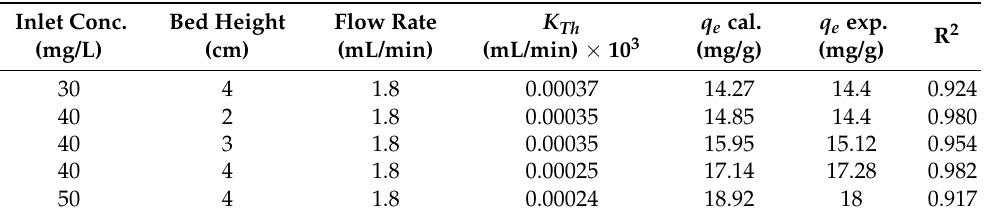
Table 5. Thomas model parameters for the adsorption of 2,4,6-TCP onto FeCl 3 -NaBH 4 /MS hybrid